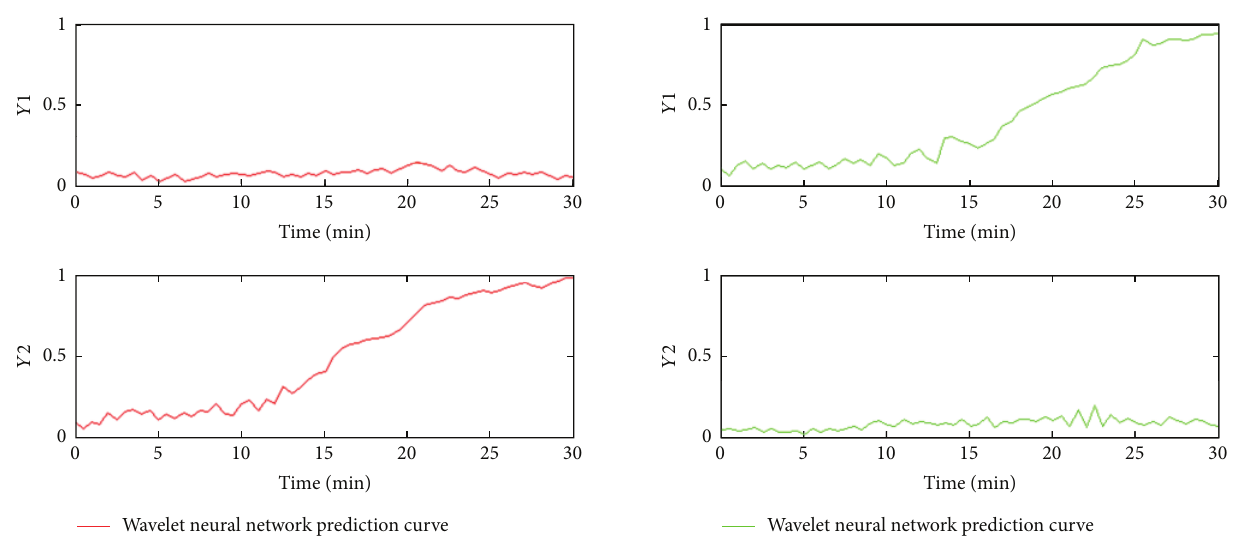
Figure 5: Anode effect fault diagnosis. Figure 6: Rolling aluminum fault